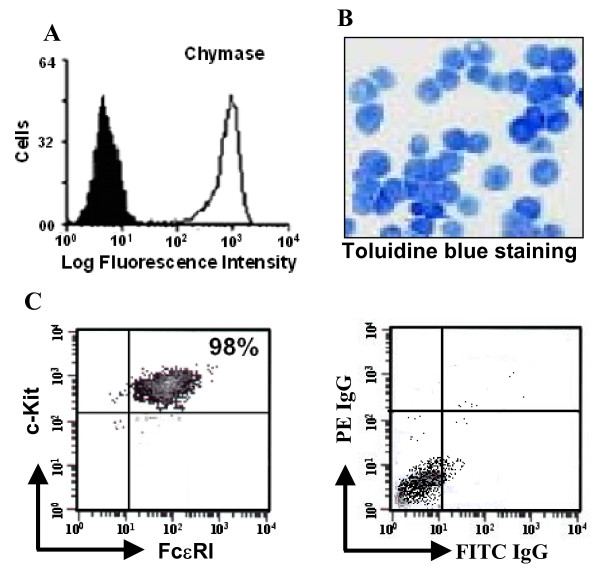
Purity of Mast cells. A. Flow cytometry analysis of intracellular chymase expression. Human cord blood-derived mast cells labelled for intracellular mast-cell chymase expression (solid line), isotype control (Black area). Results shown are representative of four separate experiments. B. Toluidine blue staining of mast cells. Fluorescence microscopy of human cord blood-derived mast cells stained with Toluidine blue. Results shown are representative of at least three separate experiments. C. Flow cytometry analysis of cell surface expression of c-kit and FcεRI. Human cord blood-derived mast cells labelled for cell-surface expression of c-kit and FceRI (left panel), and isotype controls (right panel). Results shown are representative of four separate experiments.